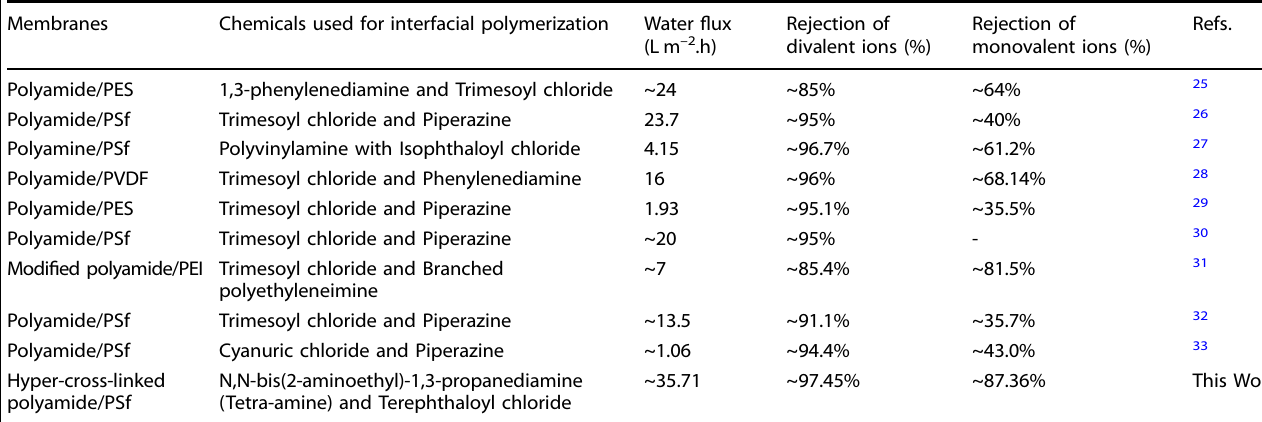
Table 1. The comparison of the HCPA-TFC-NF@M2 with membranes from literature. Membranes Chemicals used for interfacial polymerization Water fl ux